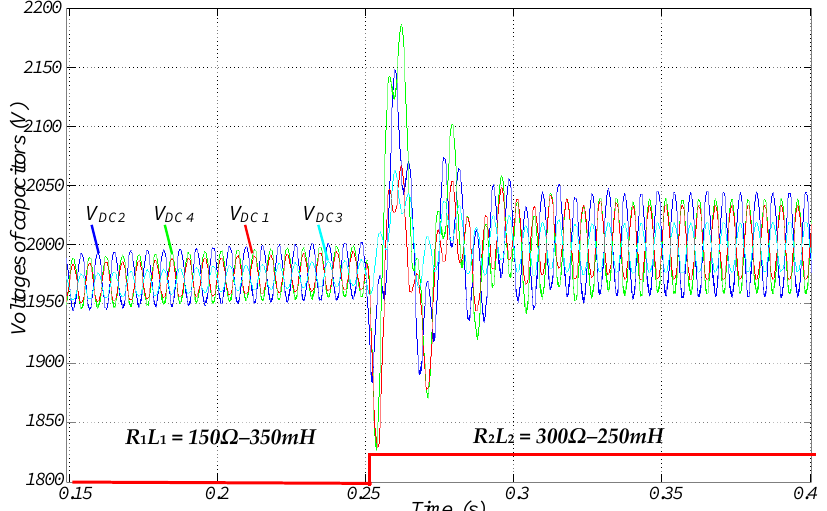
Figure 8. Simulation waveforms of the dc-link capacitor voltages ( V DC 1 - V DC 4 ).